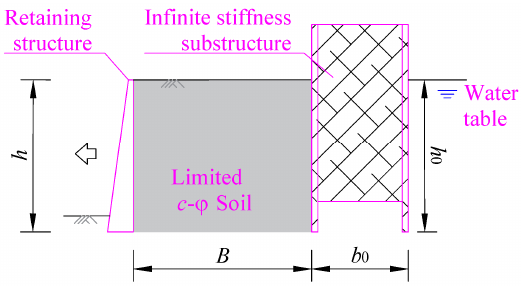
Figure 1. A deep retaining wall besides a large-rigid underground structure.